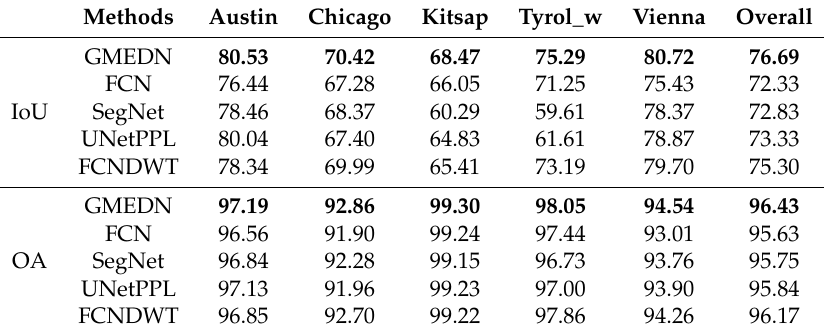
Table 1. IoU and OA scores of different methods counted by the Inria dataset (%). Methods